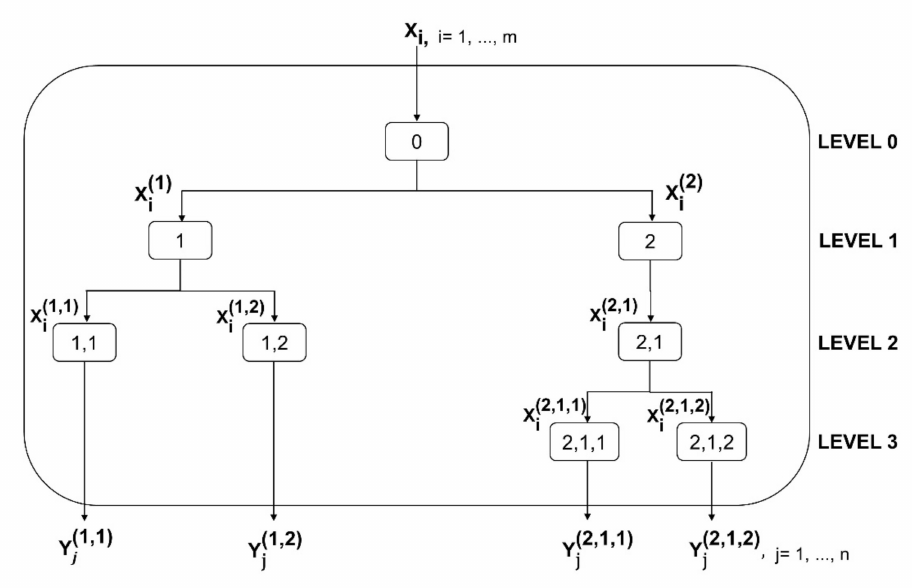
Figure 2. Illustration of the hierarchical system. Source: Adapted from